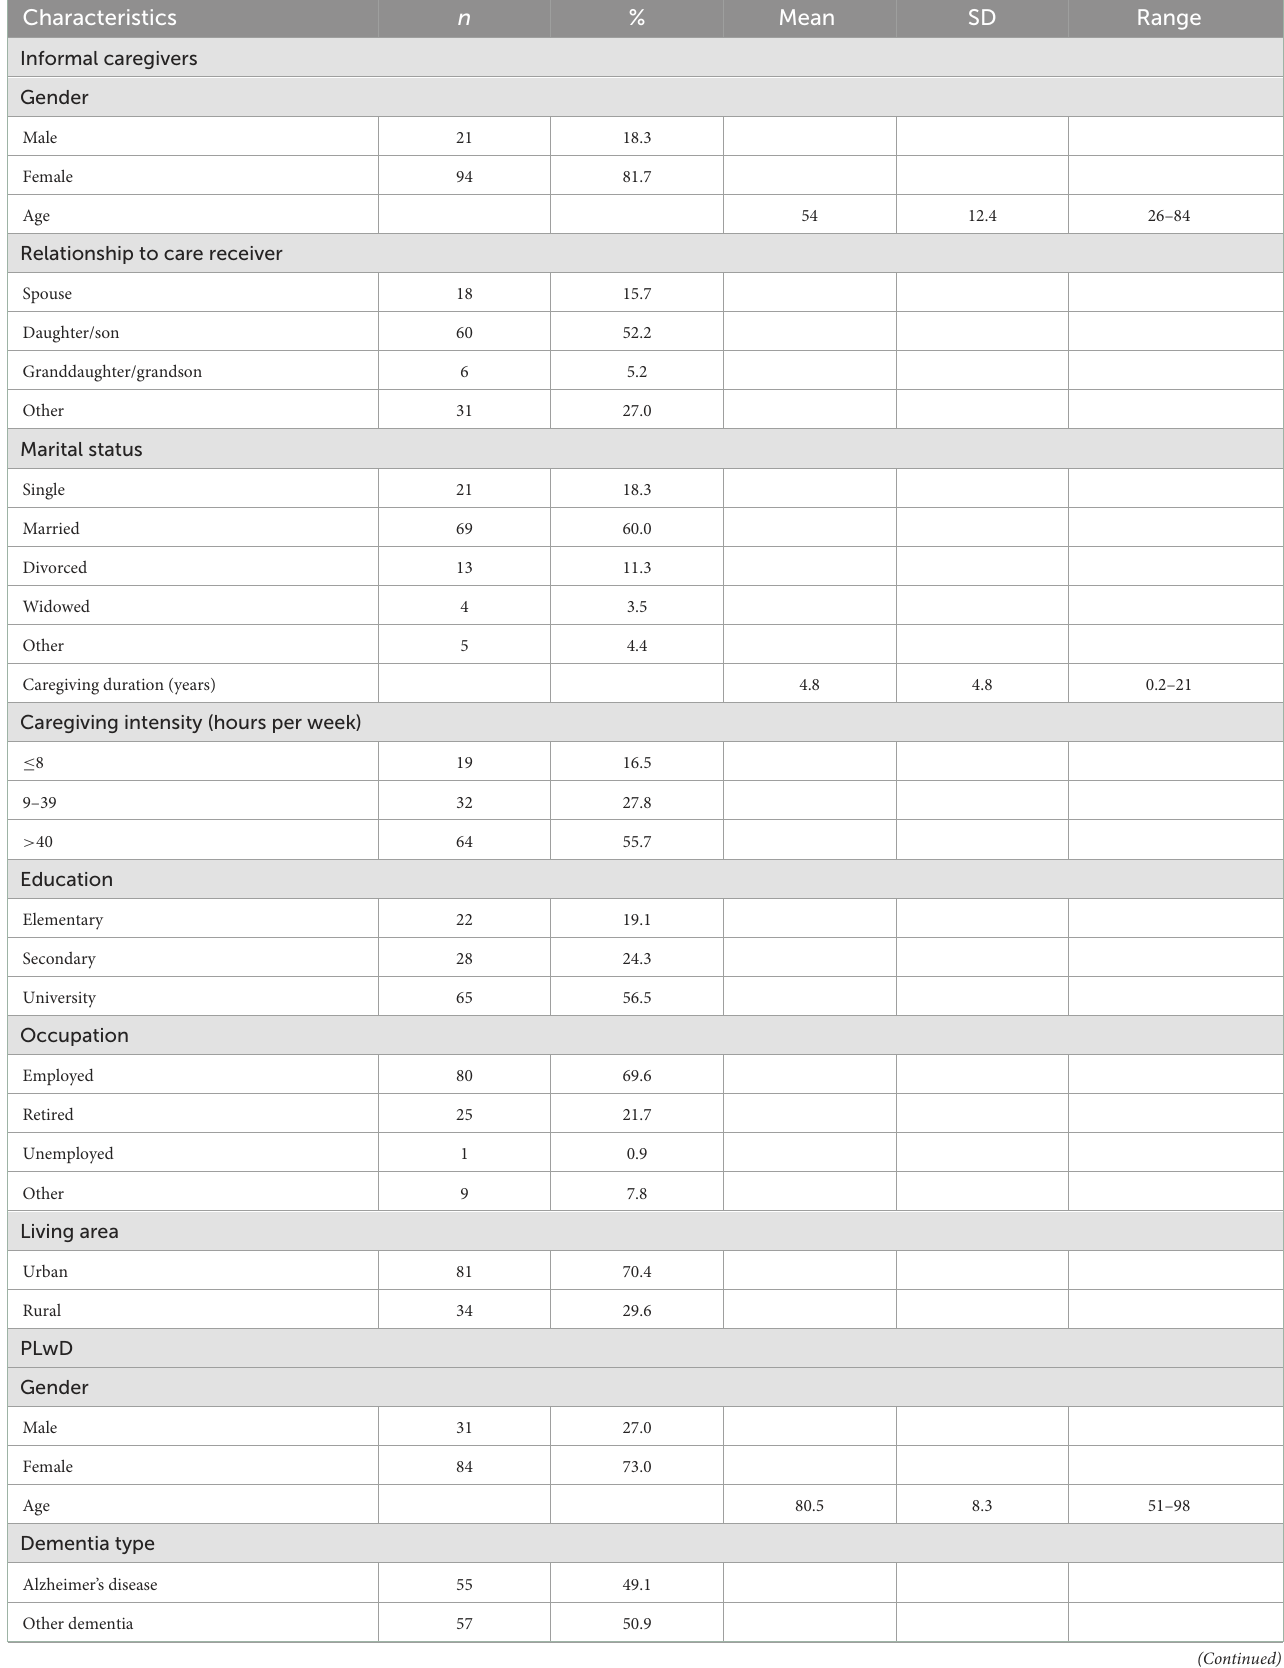
TABLE 1 Characteristics of the study sample—informal caregivers ( N = 115), persons living with dementia ( N = 115). Characteristics